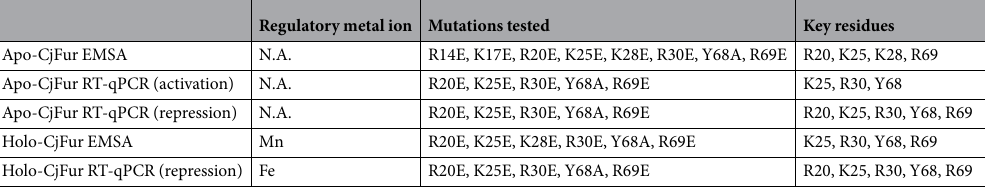
Table 1. Summary of the residues important for DNA binding in apo-CjFur and holo-CjFur. N.A. Not